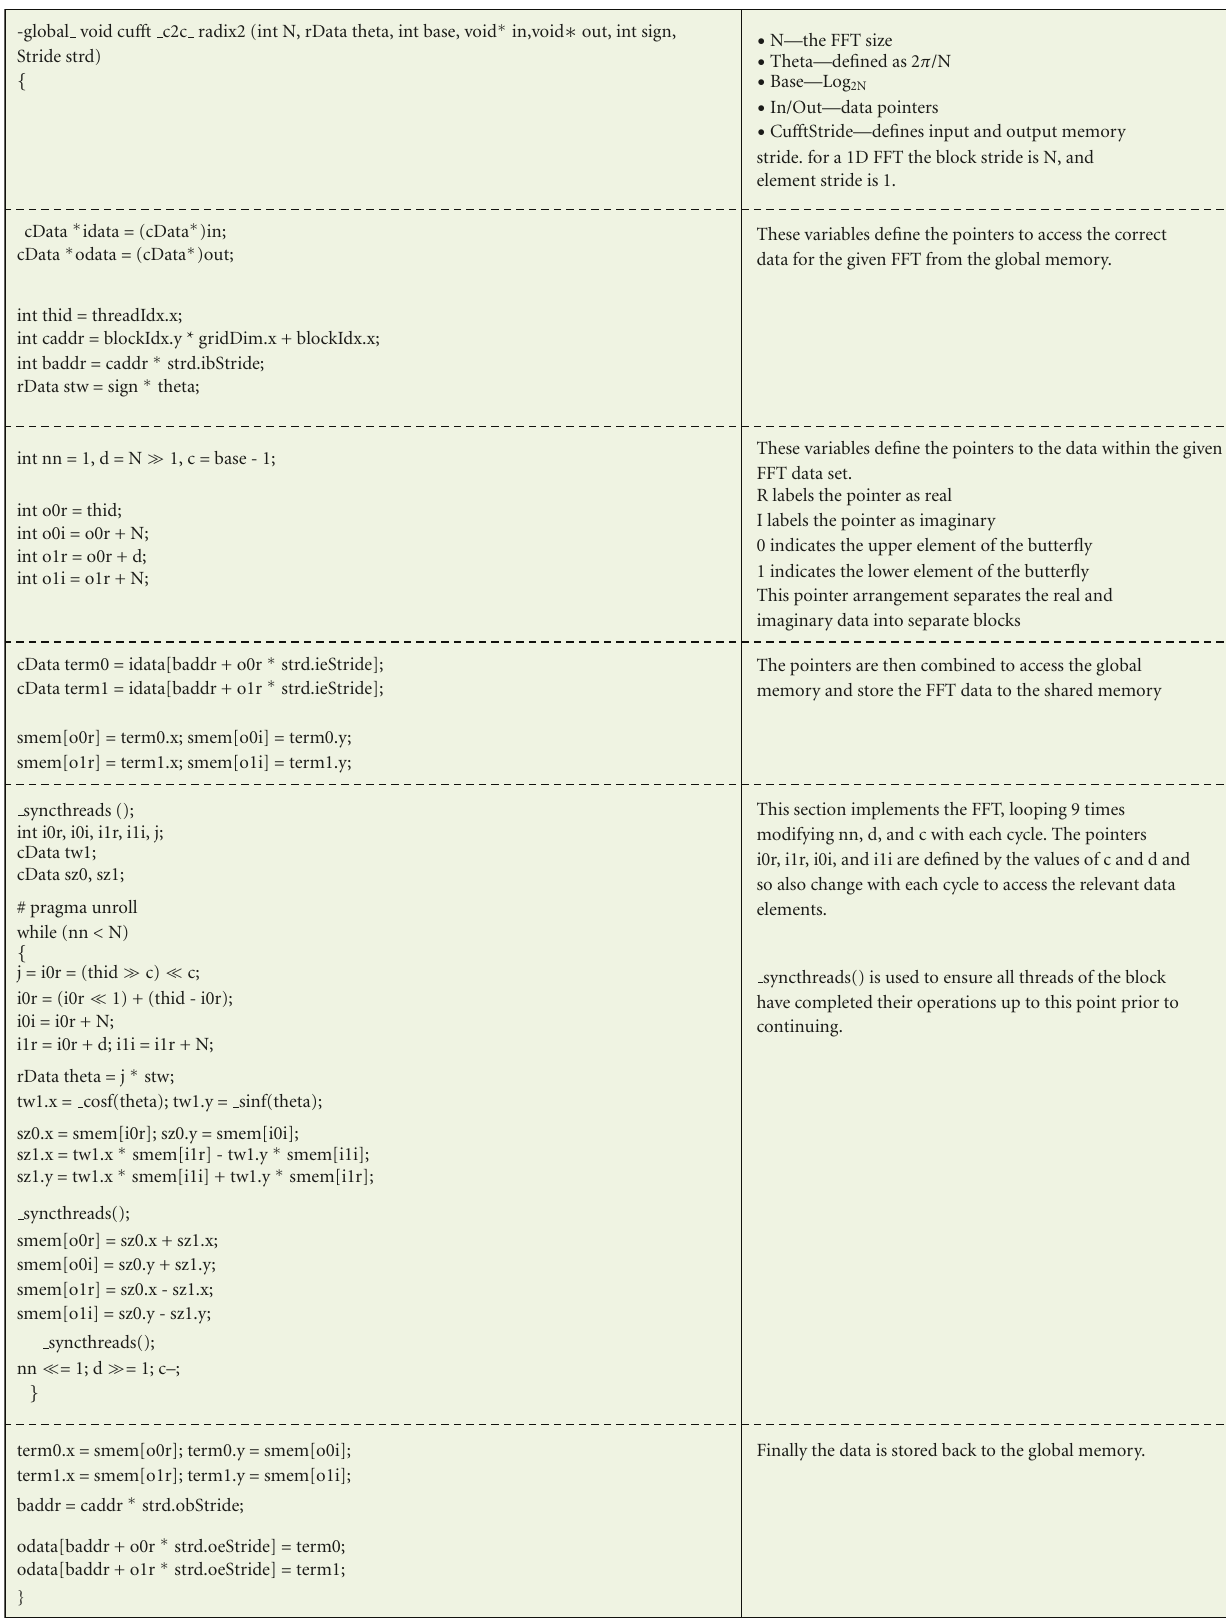
Figure 13: The CUDA FFT code [24] with explanation of its